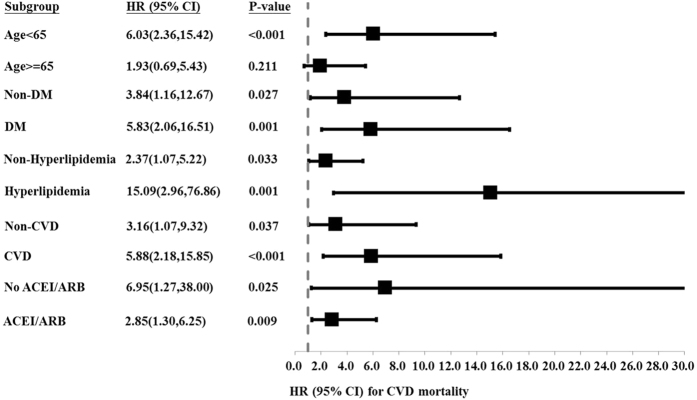
Subgroup analysis showing adjusted hazard ratios for cardiovascular disease-related mortality in the high RDW group compared with the low RDW group.